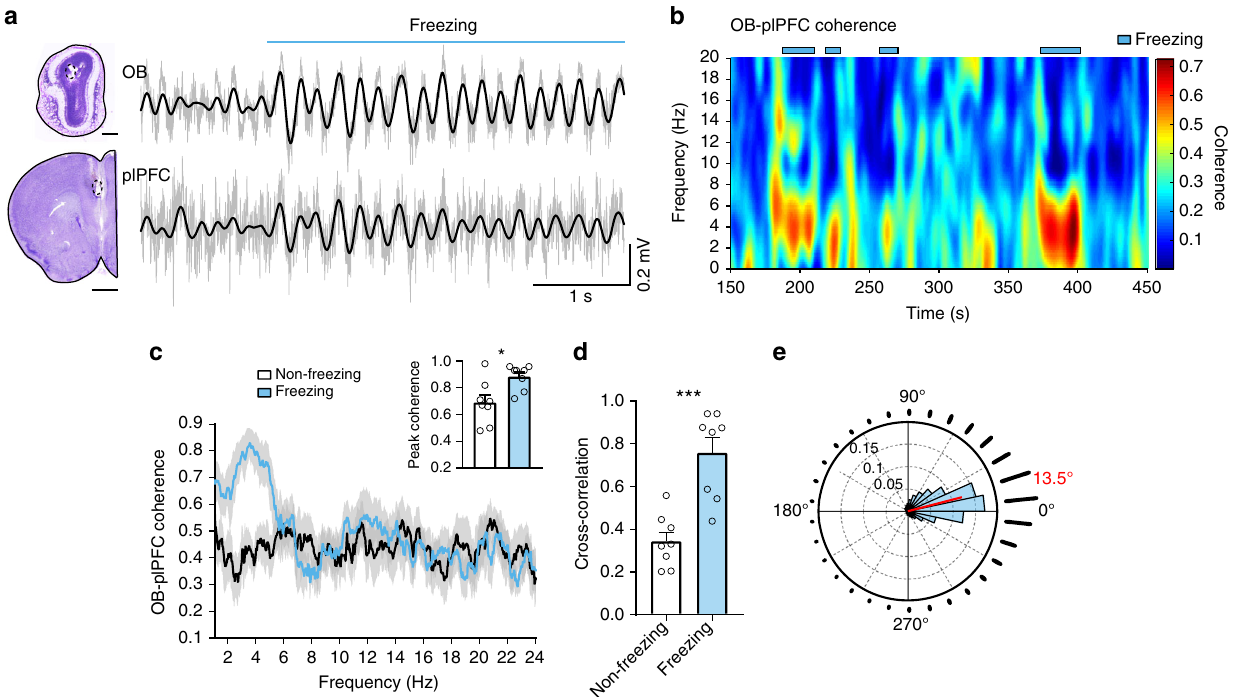
Fig. 2 During freezing, the neural activity in the OB and plPFC is dominated by highly correlated ~4-Hz oscillations. a Example OB and plPFC LFPs during a freezing epoch. Filtered signals (2 – 6 Hz) are overlaid on raw traces (gray). Nissl-stained coronal brain sections show electrode sites. Scale bars, 0.5 mm top and 1.0 mm bottom. b Time-frequency cohereogram of OB and plPFC LFPs during a portion of a retrieval session in which freezing was observed (marked in blue). High phase coherence emerges during periods of freezing. c Spectral coherence between simultaneously recorded OB and plPFC LFPs during non-freezing (from pre-tone baseline, black) and freezing (blue) periods (mean ± SEM, n = 8 mice). Inset, averaged peak coherence for non-freezing and freezing periods (0.69 ± 0.06 to 0.88 ± 0.03, n = 8, Wilcoxon matched-pairs signed rank test, p = 0.016). d All animals tested showed an increase in the maximum OB-plPFC cross-correlation value from non-freezing to freezing periods (0.34 ± 0. 04 to 0.75 ± 0.07, n = 8, paired two-tailed Student ’ s t test t (7) = 5.75, p < 0.001). The LFPs were fi ltered at 2 – 6 Hz. e Circular distribution of phase differences between OB and plPFC 2 – 6 Hz signals during freezing. The mean direction of the distribution is 13.5° (red line, with lower 95% con fi dence limit = 13.0 and upper 95% con fi dence limit = 14.0, p < 0.001 in one- sample test for mean angle equal to 0°). The phase difference distribution is also visualized as a radial histogram (30 bins) surrounding the polar